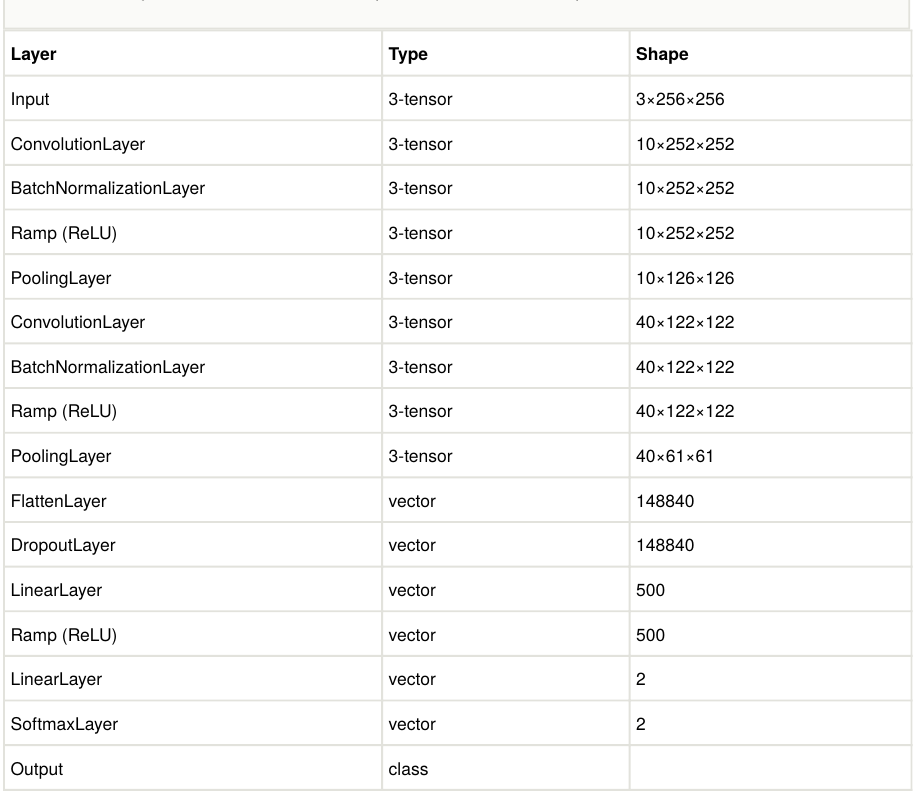
Constitutive layers and tensor/vector shapes for the clubmoss/spikemoss